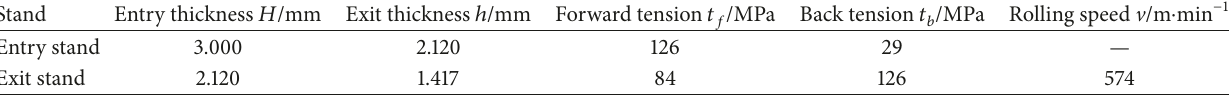
Table 1: Typical rolling schedule for simulation